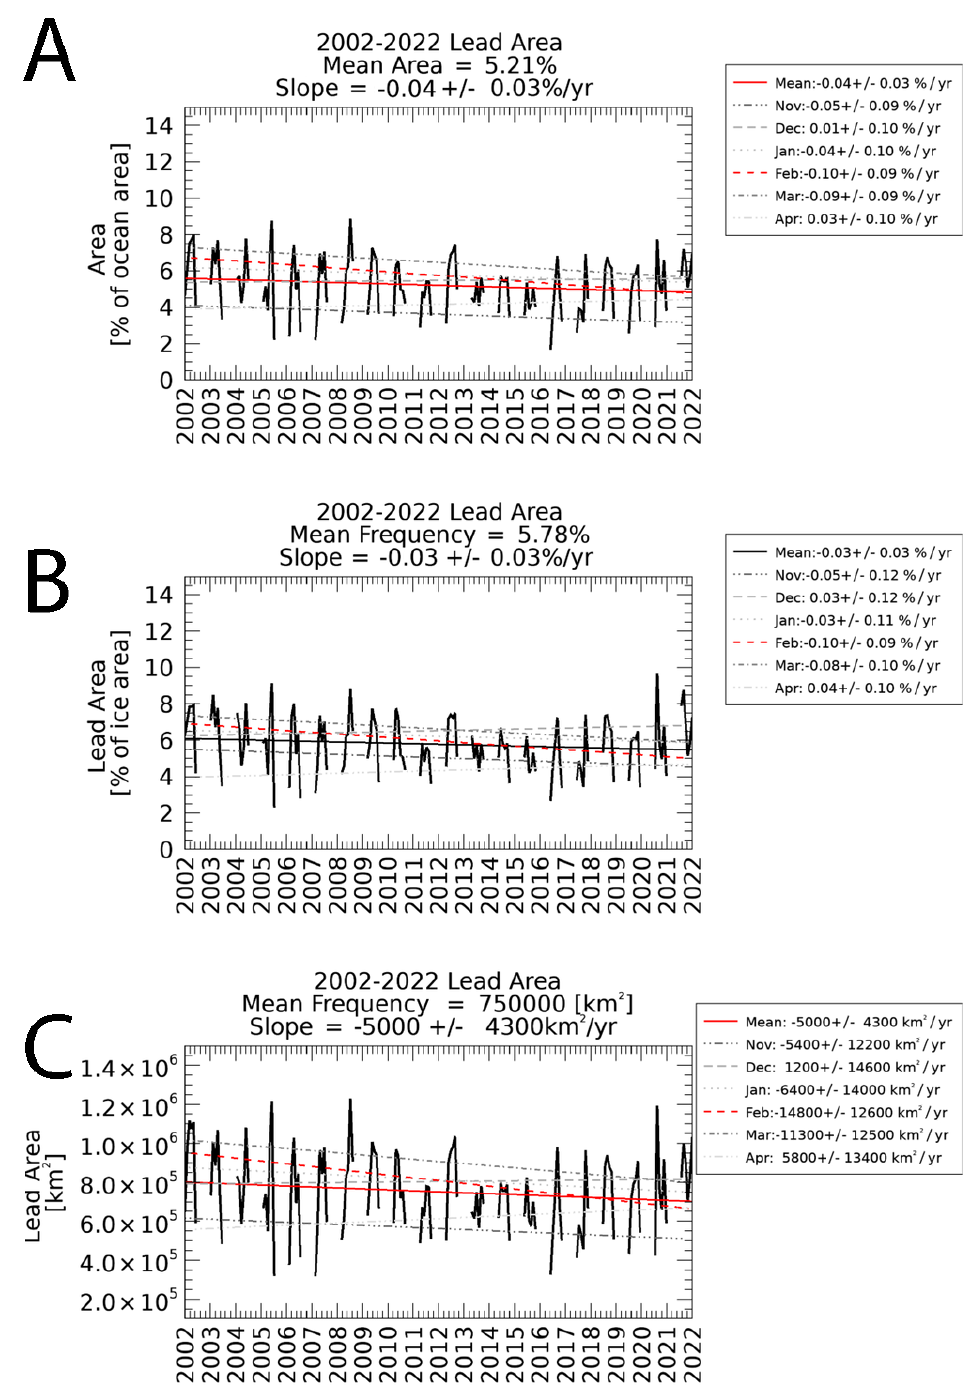
Figure 8. Lead areas represented in three different ways. In Panel ( A ), lead area is given as the average daily percent of the ocean covered by leads. Panel ( B ) shows lead detection frequency as sea ice lead areas divided sea ice areas. In Panel ( C ), daily average area covered by leads is shown. Statistically significant decreases are in red, and shades of gray are used for months with no statistically significant trend.